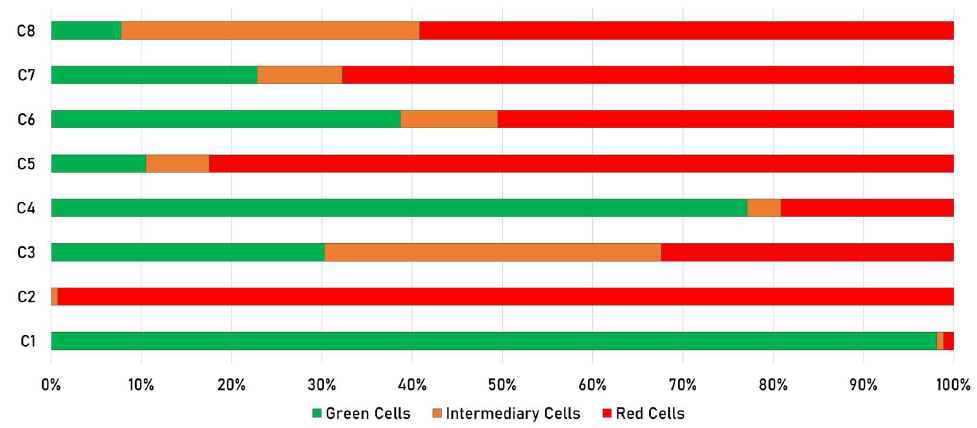
Figure 7. Results of MIFC measurements. ( C1 ) Green reference control—cultivation under moderate illumination and nitrate in the culture. ( C2 ) Red reference control—cultivation under light stress and nitrate deficiency. ( C3 ) Cultivation under light stress. ( C4 ) Cultivation under nitrate deficiency. ( C5 – C8 ) Unknown mixtures with cells from different cell stages.